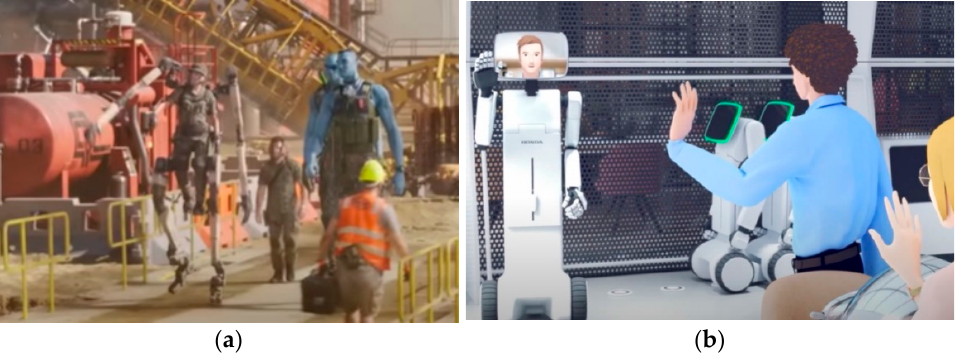
Figure 5. ( a ) The image on the left shows a manned robot in Avatar 2 (2022). ( b ) The image on the right shows an animated telepresence robot from the Honda Lab. right shows an animated telepresence robot from the Honda